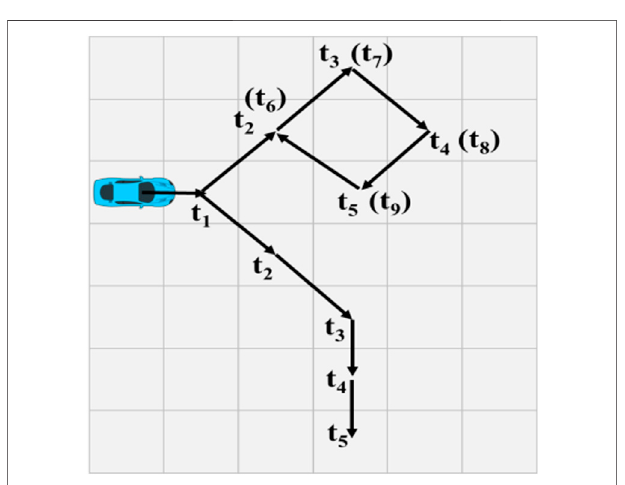
FIGURE 19 | Vehicle running in loop.